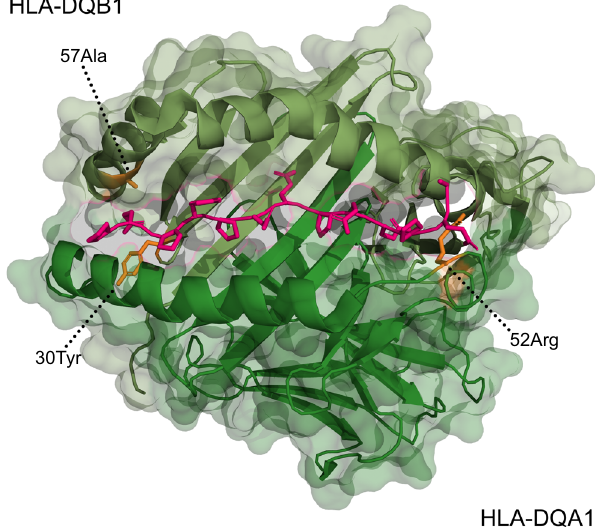
Fig. 4 Associated amino acids in the HLA-DQ heterodimer. Two amino acids in HLA-DQB1 and one amino acid in HLA-DQA1 were found to be associated with autoimmune Addison ’ s disease. A tyrosine at the 30th position and an alanine at the 57th position of HLA-DQB1 (top) and an arginine at the 52nd position of HLA-DQA1 (bottom) have been marked in orange. To visualize the binding pocket, a peptide ligand (gliadin) from the original crystal structure has been marked in